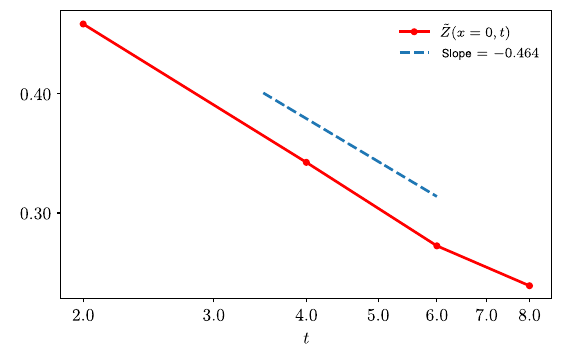
˜ Z ð x; t Þ at x ¼ 0 for the chaotic